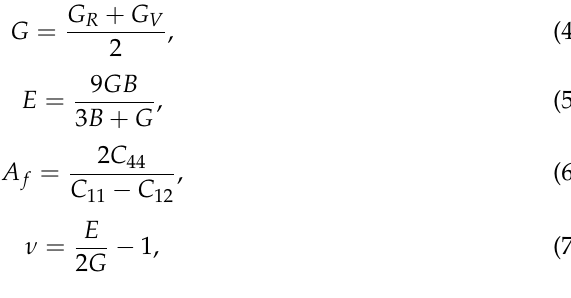
Table 2. Calculated elastic constants C 11 (GPa), C 12 (GPa), C 44 (GPa), bulk modulus B (GPa), shear modulus G (GPa), Young’s modulus E (GPa), anisotropy factor A f (arb. unit), Poisson’s ratio ν (arb. unit), and Pugh’s ratio B/G (arb. unit) of the APoO 3 perovskite. C 11 C 12 C 44 B G